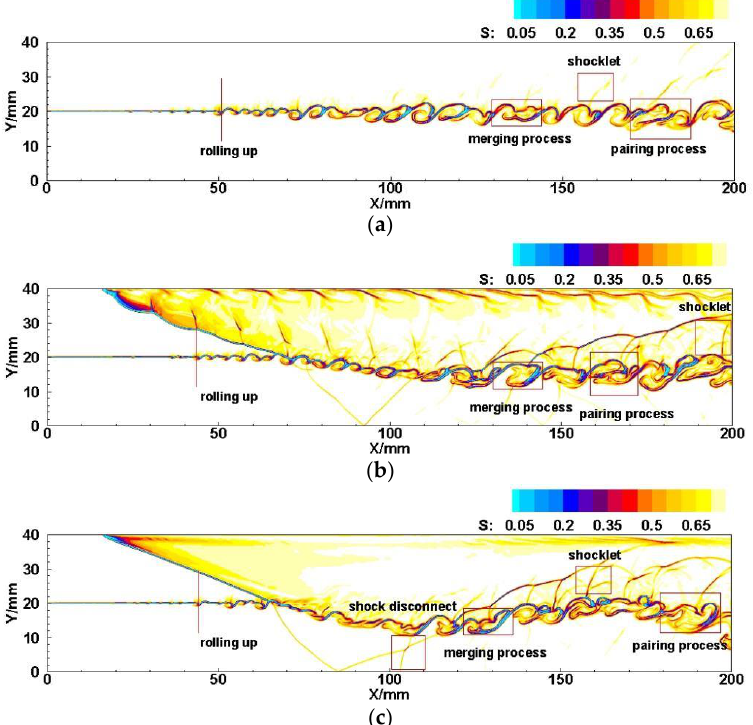
Figure 6. instantaneous flow structures of present three cases: ( a ) Case 1; ( b ) Case 2; ( c ) Case 3. In Case 1, the mixing layer develops around the central region of the flow field. How- ever, in Case 2 and Case 3, due to the introduction of jet shock, the mixing layer is de- flected downward after the incident shock, then deflected upward after the reflection shock. Meanwhile, the jet shock is first refracted through the mixing layer, then reflected upward on the lower wall, and then again refracted on the mixing layer. Refraction shock interacts with shocklets and finally becomes segmented state. Relative to Case 1, a new phenomenon of vortices rolling up closer to the inlet can be seen in Case 2 and Case 3, indicating that there are subsonic regions at the shock/mixing interaction area. This leads disturbance to transmit backward and can promote the vortices to roll up. Compared Case 2 with Case 3, it can be found that incident shock will be segmented in Case 2, while rela- tively straight in Case 3. Fast jet frequency in Case 2 makes the shock wave propagation speed lower than the jet disturbance speed, eventually it causes the ‘ disconnection ’ phe- nomenon. Overall, the vortex structures belonging to the interaction region possess char- acteristics of coexistence of both large- and small- scale vortices, and this dynamic is of great importance for promote mixing. Thus, detailed analysis concerning the structure behaviors is essential. To better analyze the interaction process between jet shock and mixing layer in case 3, the detailed visualization around the interaction position is presented in Figure 7. One important phenomenon is that compared to the interaction process in case 2, in case 3 the interaction position is not fixed. In Figure 7a the interaction position located at x = 83 mm approximately, while in Figure 7b at about x = 62 mm. Indeed, by analyzing our calculated results it can be found that these two positions correspond to the farthest and nearest in- teraction locations in the flow field. Through reviewing previous literatures focusing on shock induced by wedge shock generator and its interaction process with mixing layer [23] , it can be concluded that the interaction position was fixed and can be called the ‘point action mode’(P AM). However, in present work new mode never reported before is found